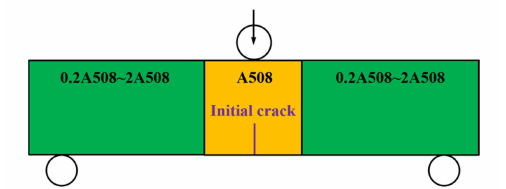
Figure 2. The structure and materials of the first crack-branching